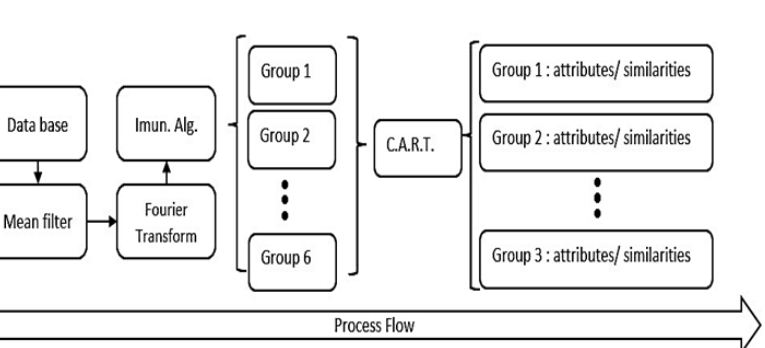
Figure 4. Data pipeline steps. All data were filtered, and a Fourier transform was applied before using the IA. As a result of IA, each sample would receive a group number based on Fourier spectrum similarities (result from IA processing). The group information was used as an outcome for the CART. After CART processing, the result was a list of N groups with similar gait